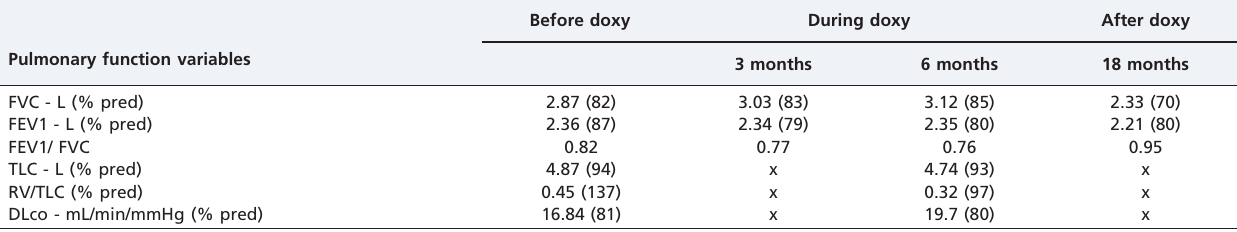
Table 1 - Pulmonary function tests performed before and during doxycycline treatment and 18 months after doxycycline interruption. Before doxy During doxy After doxy Pulmonary function variables